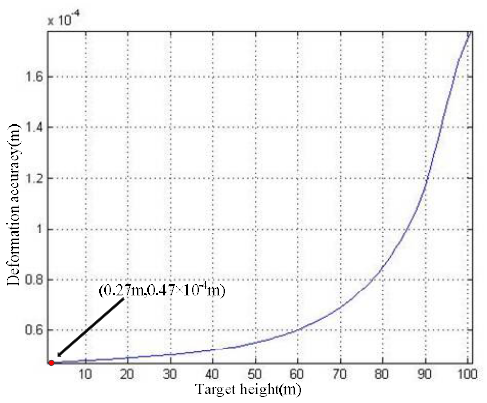
Figure 17. h – σ d Figure 17. h – σ d curve.